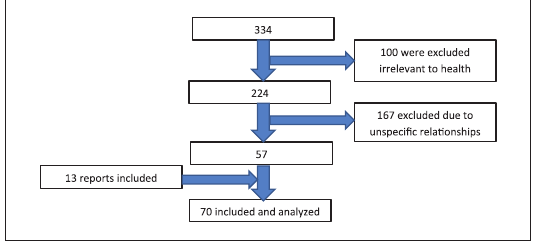
Figure 1: Flowchart for inclusion of studies and reports on trends in China international multilateral cooperation initiatives in health development and global infectious diseases control and